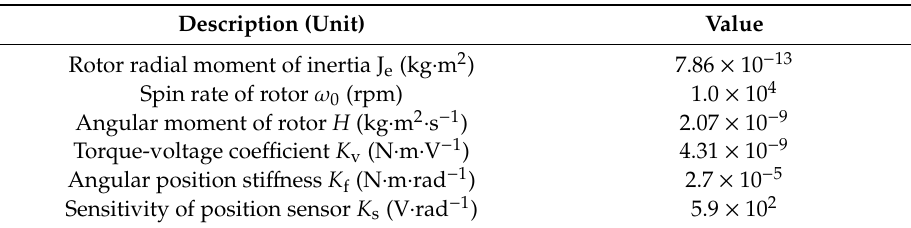
Table 2. Parameters of the dual-axis MESG rebalance loop.